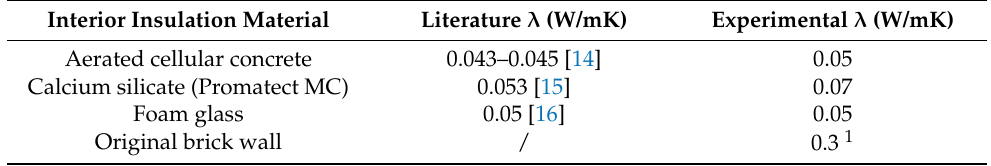
Table 1. The expected thermal conductivities (Literature λ ) and the measured ones (Experimental λ